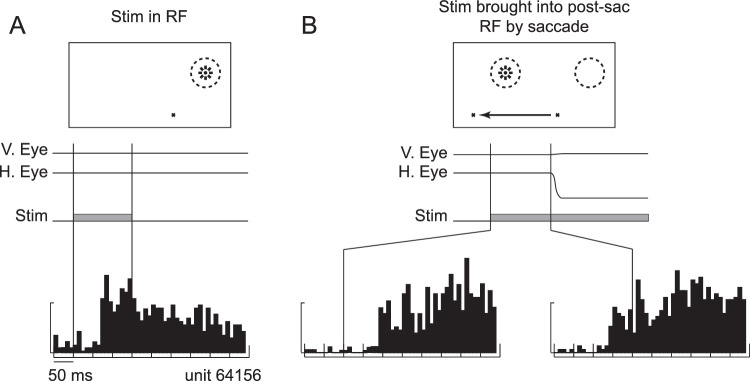
Predictive remapping of activity in a single LIP neuron. (A) The response of the neuron to a stimulus (Stim) flashed in its response field (RF), aligned by stimulus onset. (B) The response of the neuron to a stimulus brought into the postsaccadic RF by a saccade. The histogram on the left is aligned by stimulus onset, and the histogram on the right is aligned by saccade onset. V. Eye: vertical eye position. H. Eye: horizontal eye position. Modified from Duhamel, Colby, and Goldberg (1992) with permission.